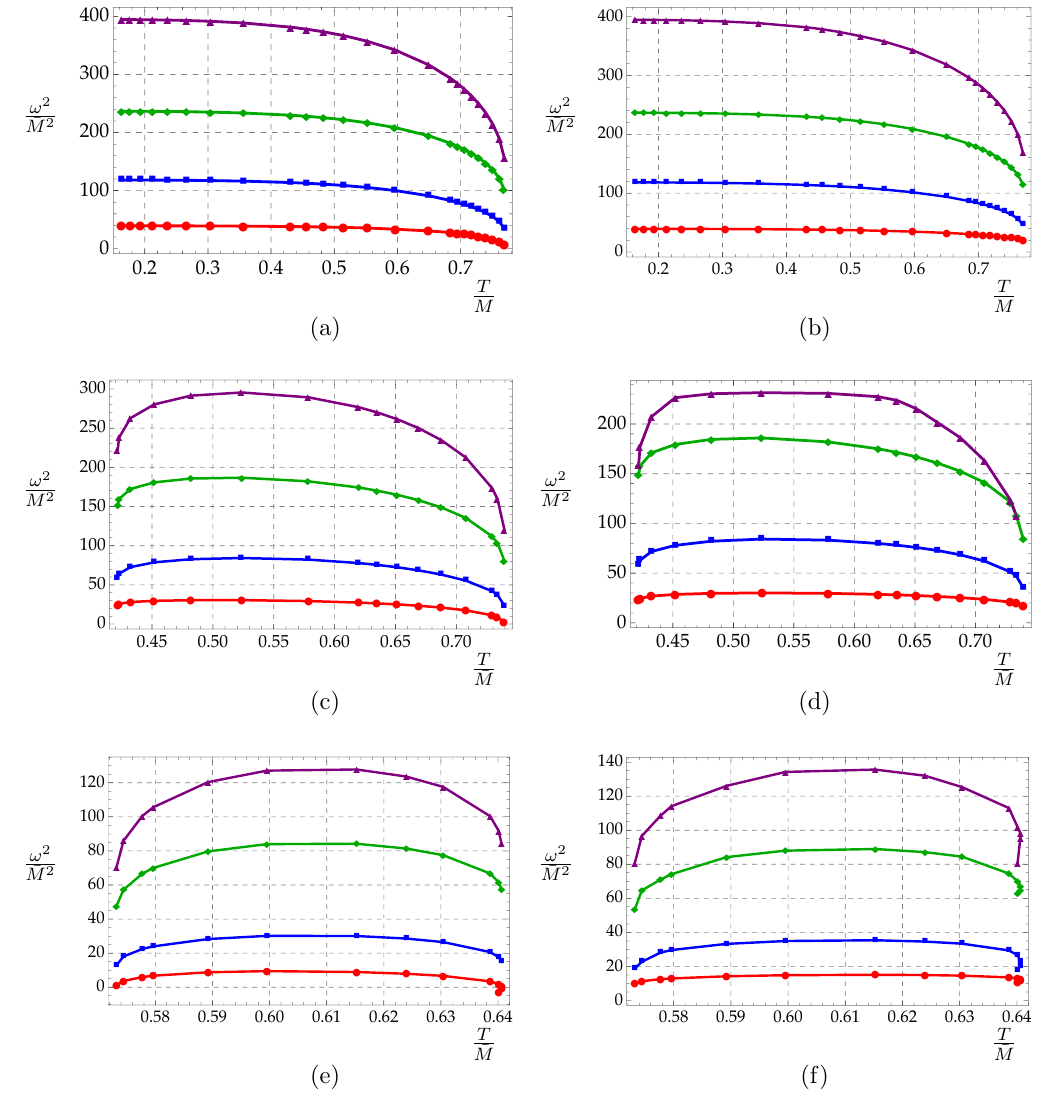
Figure 14 . Meson spectrum ! 2 for the (cid:31) (left column) and (cid:30) (right column) perturbations as (cid:22) M 2 a function of T= (cid:22) M for (cid:12)xed magnetic (cid:12)eld b= (cid:22) M 2 = 0 (a) and (b), 2 (c) and (d), and 3.4 (e) and (f). The di(cid:11)erent colors correspond to di(cid:11)erent quantum numbers ( n; l ) of the mesons, being from bottom to top red (0 ; 0), blue (1 ; 0), green (0 ; 2), and purple (1 ;